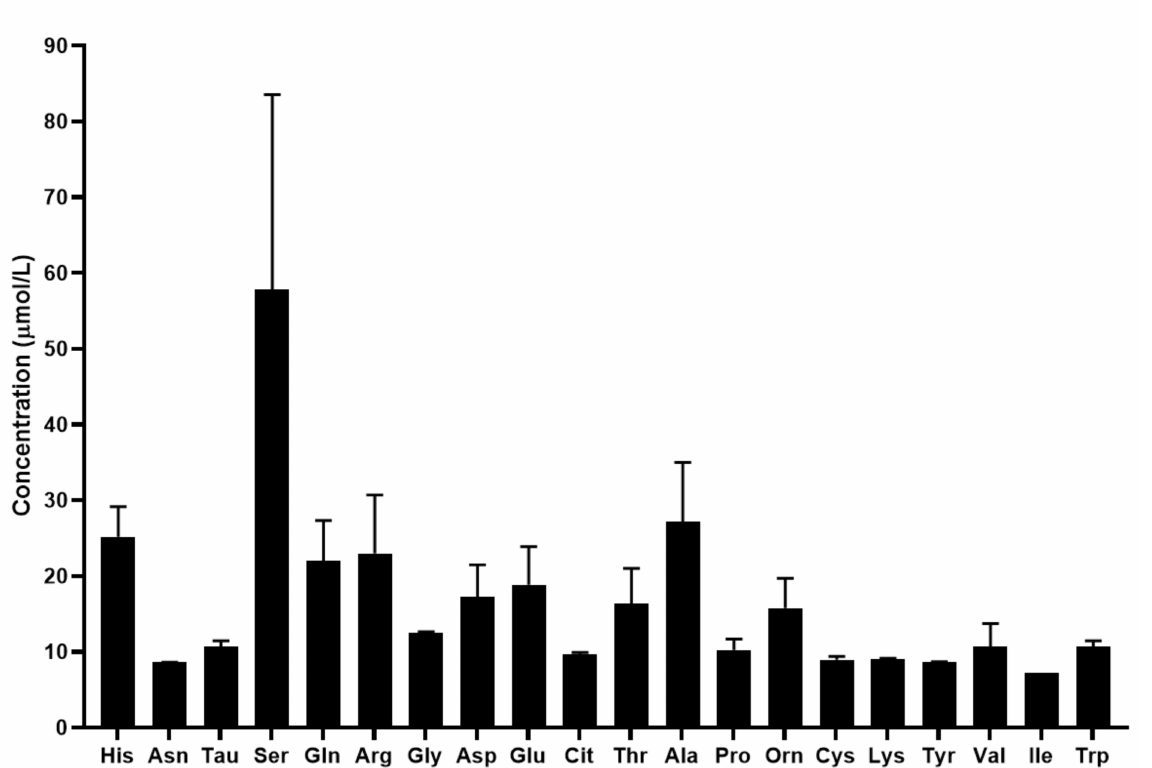
Figure 4. Concentration of the quantified amino acids and biogenic amines in tears in µ mol/L. For amino acids the three-letter code was used, Tau: